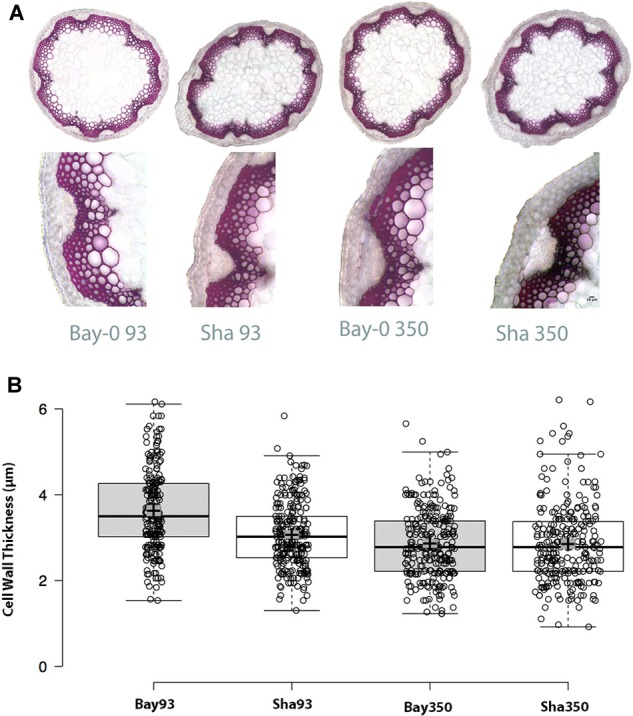
(A) Phloroglucinol stained cross sections with representative focus areas for measurements. (B) Cell wall thickness variation between Bay-0 and Sha NILS. CESA4Bay NIL93 was the only line to exhibit slightly thicker cell walls, while the other three lines were similar. Center lines show the medians; box limits indicate the 25th and 75th percentiles as determined by R software; whiskers extend 1.5 times the interquartile range from the 25th and 75th percentiles; crosses represent sample means with surrounding gray box indicating 95% confidence interval.